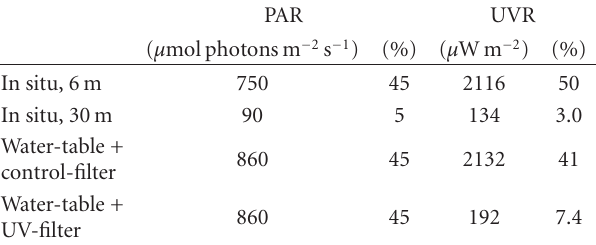
Table 1: Midday values of PAR and UVR and percentage trans- mittances (%) of the in situ downwelling (at 6 and 30 m) and 50%-shaded water-table (under the control- and UV-filters) PAR (400–700 nm) and UVR (300–400 nm). The water-table values were measured on April 10, 2007, and the in situ values were measured on April 1, 2008, o ff shore the IUI, with the PRR-800 profiling radiometer (BioSpherical Instruments).